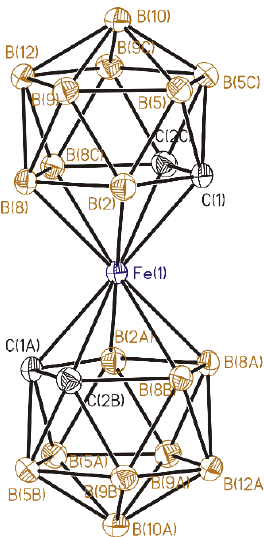
Figure 2. Crystal packing fragment of ( 1 ). A view along the b axis. The unit cell is outlined. H at- oms are omitted for clarity.